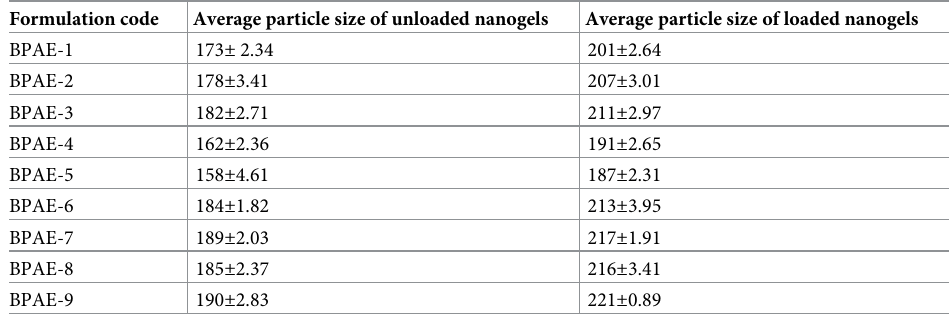
Note. All values are expressed as mean ± SD (n =